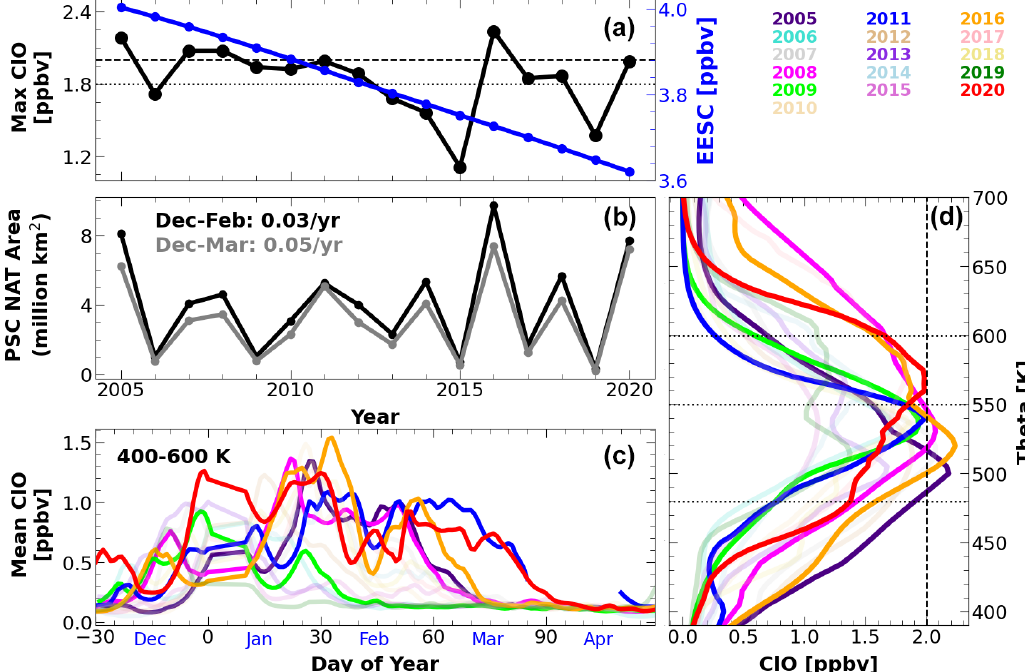
Figure 6. PSC and chlorine activation in the Arctic winters of 2005–2020. (a) The temporal evolution of ClO in the Arctic winters as measured by the Microwave Limb Sounder (MLS) inside the vortex and effective equivalent stratospheric chlorine (EESC). (b) The area of PSC averaged for the period December–February and December–March (grey) for the winter since 2005. (c) The maximum ClO measured inside the vortex in each winter from 2005 to 2020. (d) The maximum ClO profiles measured inside the vortex for Arctic winters since 2005. The high chlorine activation with high ClO values is shown in bright colours and others are faded in (a) and (c) . Since the chlorine activation timing is different in different winters, the peak ClO observed between December and April/March are